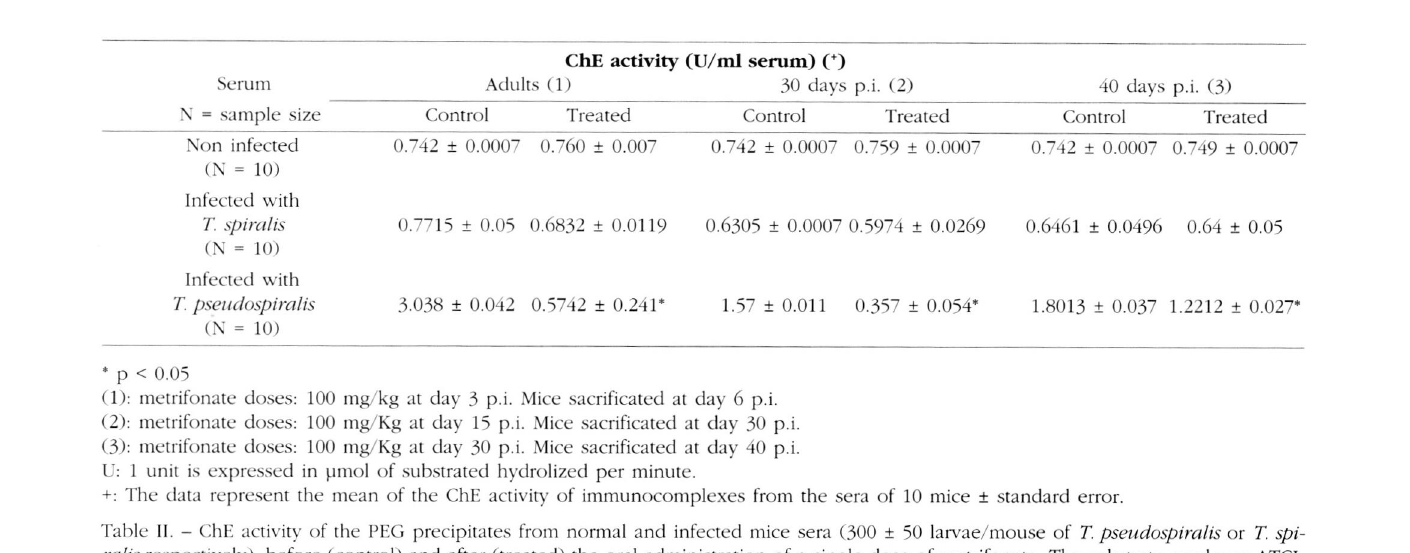
Table II. - ChE activity of the PEG precipitates from normal and infected mice sera (300 ± 50 larvae/mouse of T. pseudospiralis or T. spi ralis respectively), before (control) and after (treated) the oral administration of a single dose of metrifonate. The substrate used was ATCI.